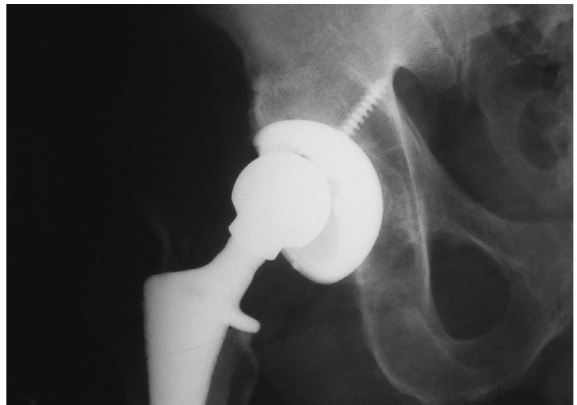
Figure 2: Patient 2: anteroposterior radiographs demonstrating eccentric placement of the femoral head within the acetabular polyethylene and excessive acetabular component